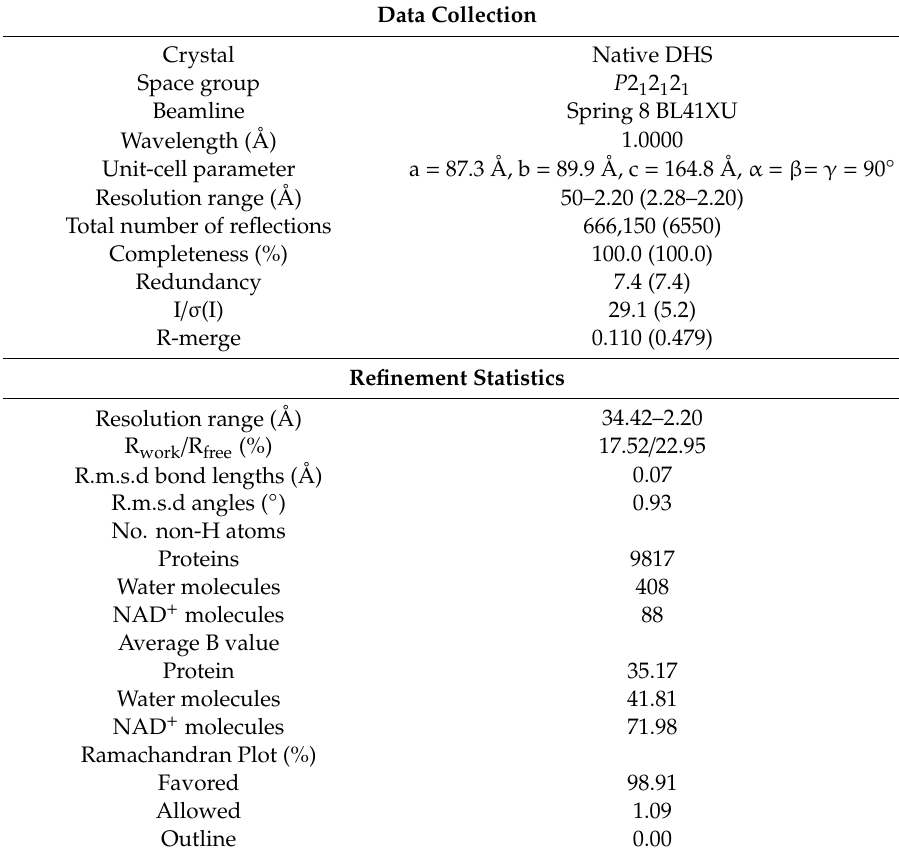
Table 1. Summary of data collection and refinement